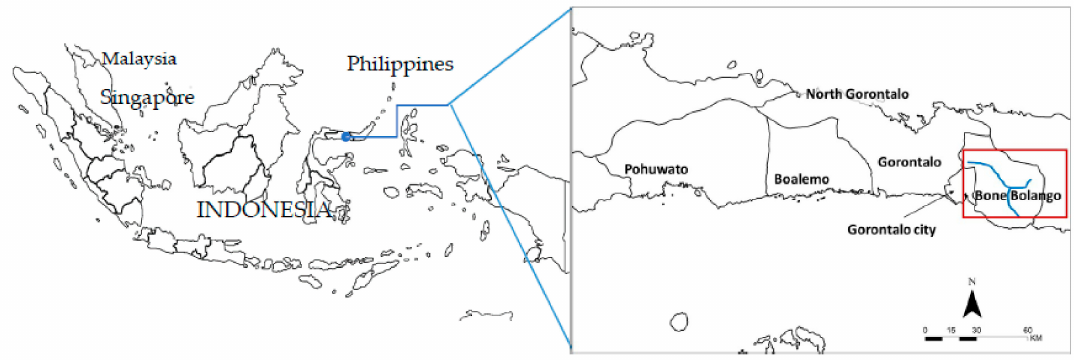
Figure 1. Field site